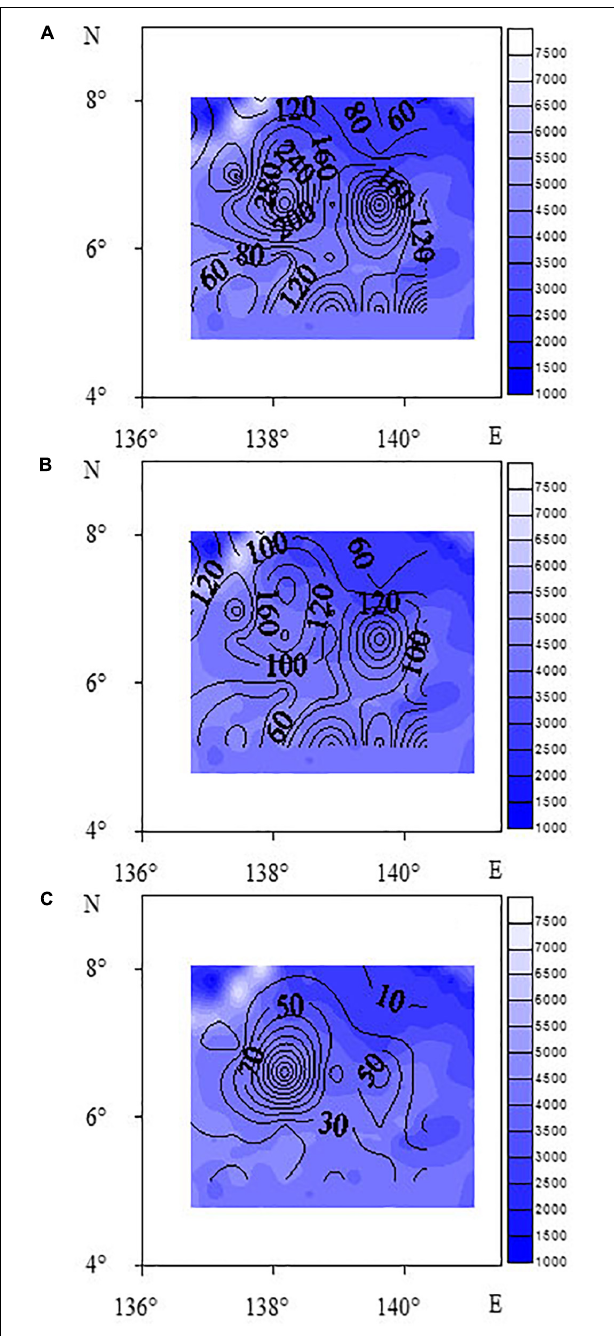
FIGURE 3 | Contour maps of abundance of meiofauna (A) , nematodes (B) , and benthic copepods (C) (unit: ind · 10 cm - 2 ).